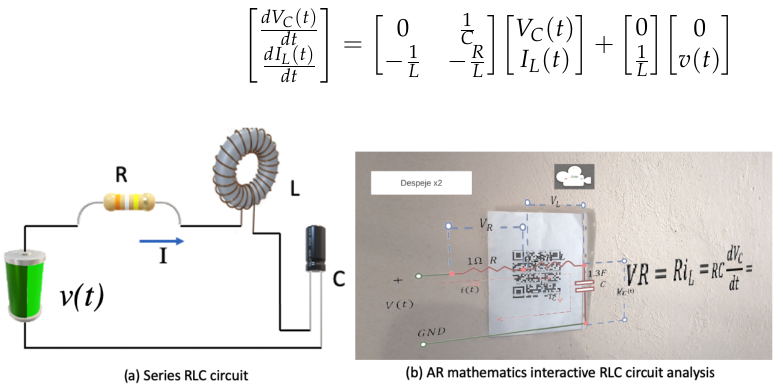
Figure 6. RLC circuit: AR GUI interactive RLC circuit mathematics